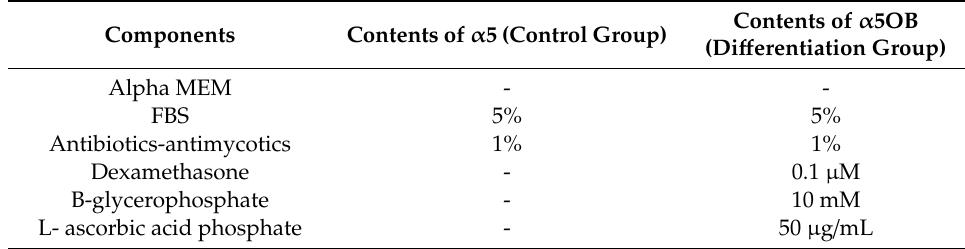
Table 3. Odontogenic di ff erentiation